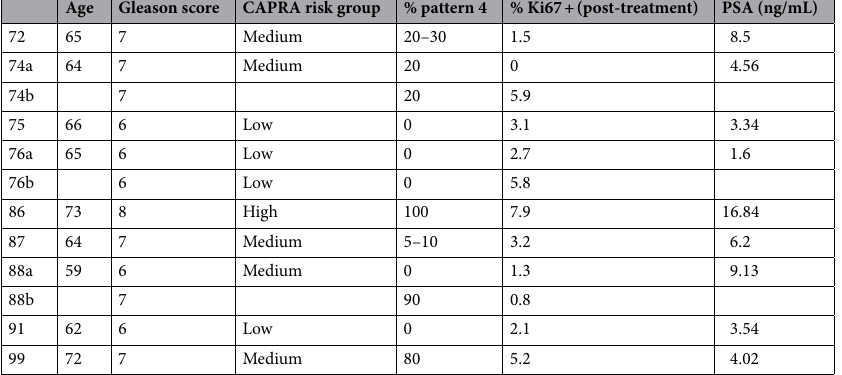
Table 5. Summary of disease markers in patient cohort receiving HDR-BT for prostatic